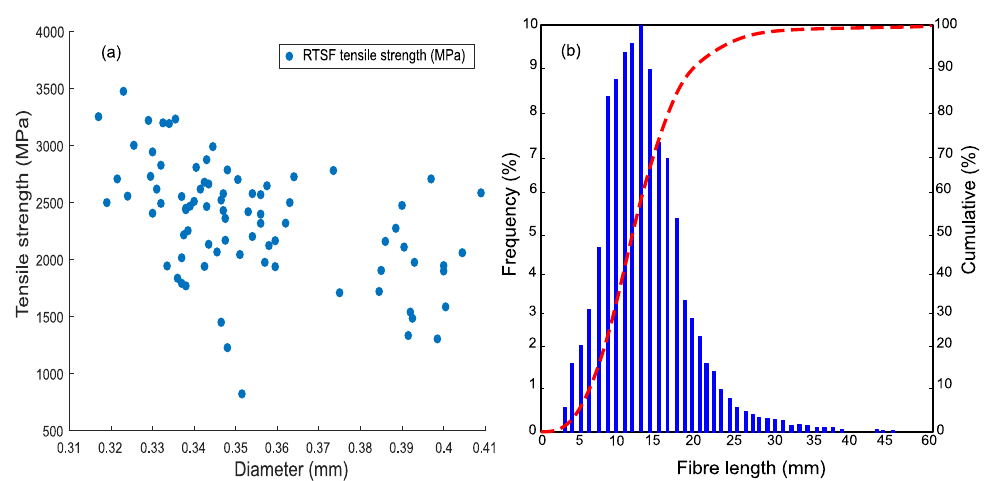
Figure 3. RTSF. Figure 3. RTSF.